Question: Draft a figure caption describing what is shown.
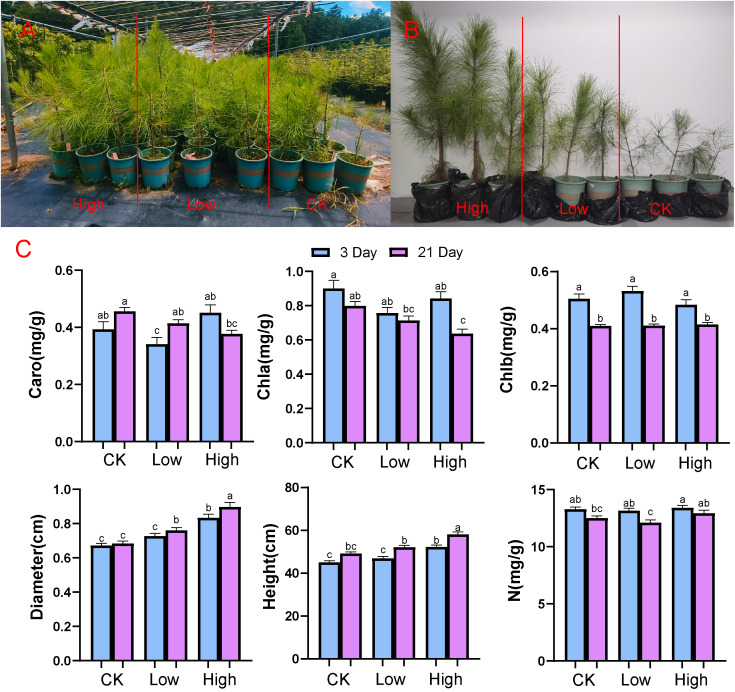
Answer: Growth status of slash pine seedlings and determined phenotypic analysis. (A) Growth status of all potted slash pine seedlings in the experiment, arranged from left to right as the high-nitrogen, low-nitrogen, and control groups. (B) Nine seedlings selected from the three groups (arranged from left to right as high-nitrogen, low-nitrogen, and control groups) for the determination of malondialdehyde, proline, and reactive oxygen species. (C) Blue bars represent phenotypic values sampled on day 3, and red bars represent those sampled on day 21. From left to right are the control group, high-nitrogen group, and low-nitrogen group. Different lowercase letters in the column (A–C) signify significant differences between two varieties under various treatments for the same index ( p < 0.05).